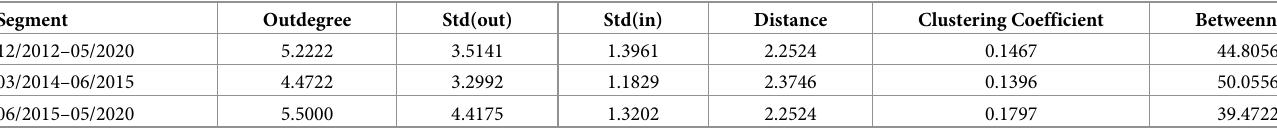
Table 4. Results of region index over three